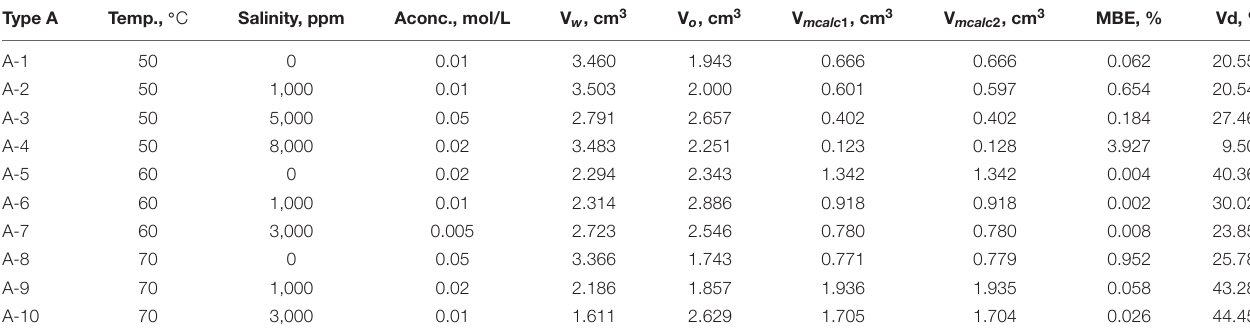
TABLE 1 | NaOH orthogonal test phase migration volume fraction of 3-phase distribution cases.